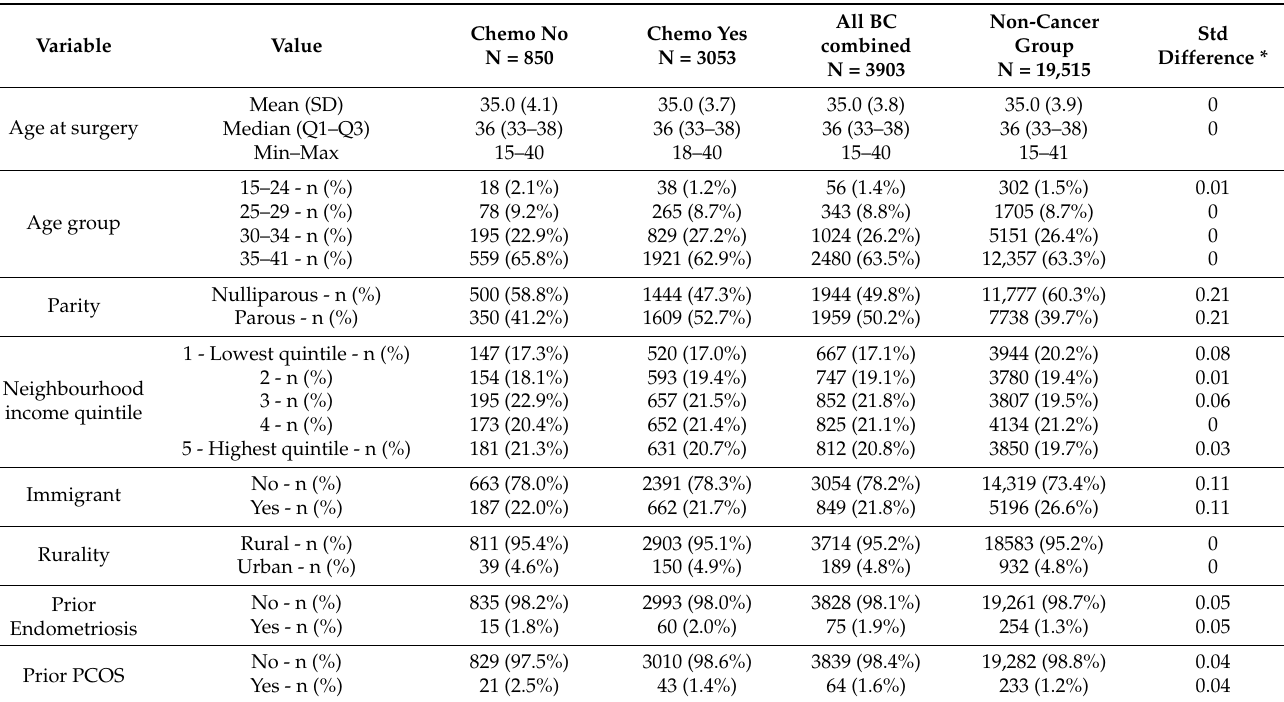
Table 1. Baseline Characteristics and standardized differences between 3903 women age 15–39 years with breast cancer and 19,515 cancer-free women in Ontario, Canada from